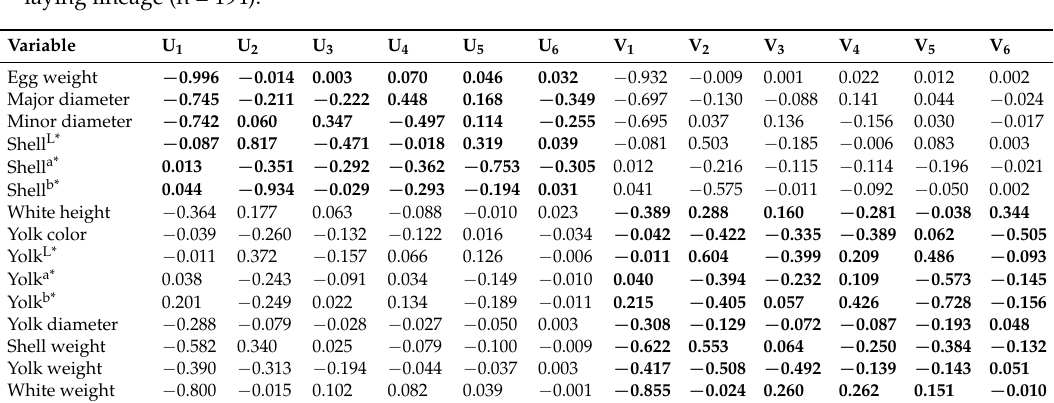
Table 4. Correlations between the variables and related canonical variables (canonical loadings) and between the variables and the other set of canonical variables (canonical cross-loadings) for internal and external egg quality-related traits, excluding yolk and white pH, in Utrerana hens compared to laying lineage (n =